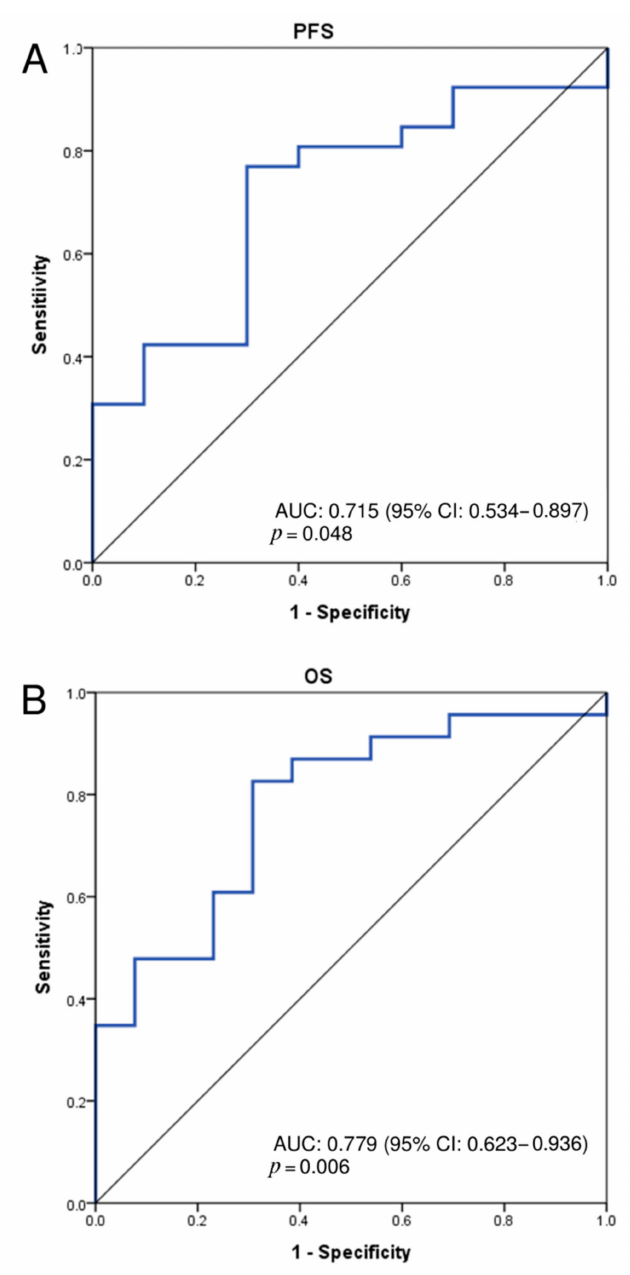
Figure 2. Receiver-operating characteristic curves for ( A ) progression-free survival AUC = 0.715 and ( B ) overall survival AUC = 0.779. AUC, area under the curve; CI, confidence